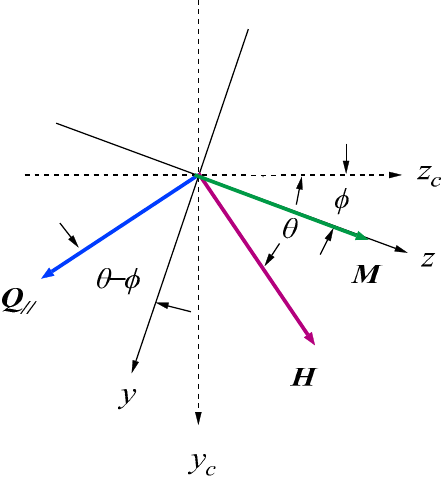
Figure 10. Schematic illustration on the magnetization rotation by the external magnetic field ap‑ plied in the y – z plane. The magnetic field was applied along the θ direction measured from the crystal easy axis z C . The rotation angle of the magnetization measured from the easy axis ϕ can be determined by Equation (65). BLS observed the SWs propagating along the y direction, which is always perpendicular to the external magnetic field.